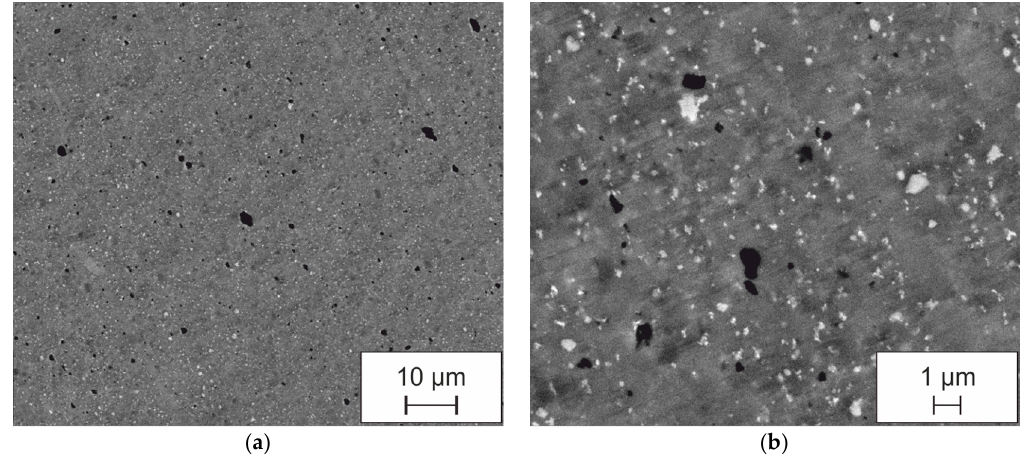
Figure 2. SEM images (SE) on the ion-etched cross section of an AMC reinforced with 10 vol % SiC and 3 vol % boron; matrix material: AA2017; size of the SiC and B particles: about 1 μ m; B-containing phases (black), IM phases (white), SiC particles (hardly contrasted); ( a , b ) with different magnification.